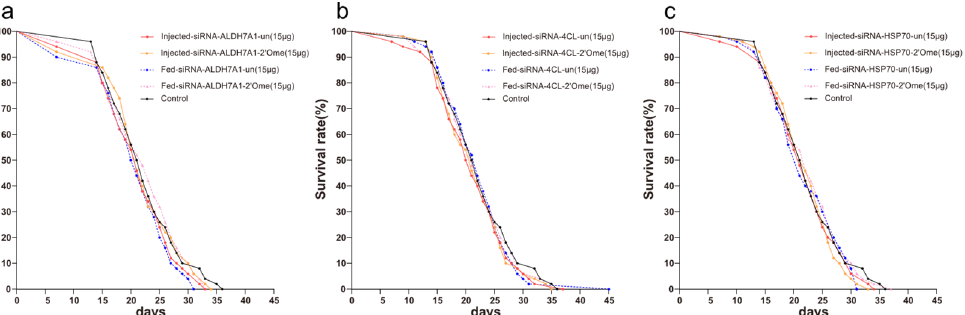
Figure 1. Survival curves of honey bees after the injection and feeding of siRNA. ( a ) Effects of different delivery methods and different modified siRNAs on the survival rate of honey bees. Red solid line represents the injection of unmodified siRNA-ALDH7A1; Orange solid line represents the injection of 2 ′ Ome modified siRNA-ALDH7A1; Blue dashed line represents the feeding of unmodified siRNA-ALDH7A1; Pink dashed line represents the feeding of 2 ′ Ome modified siRNA-ALDH7A1; Black solid line represents honey bees without any treatment. ( b ) siRNA-4CL and ( c ) siRNA-HSP70 were used, otherwise consistent with ( a ). Each group has 50 honey bees.